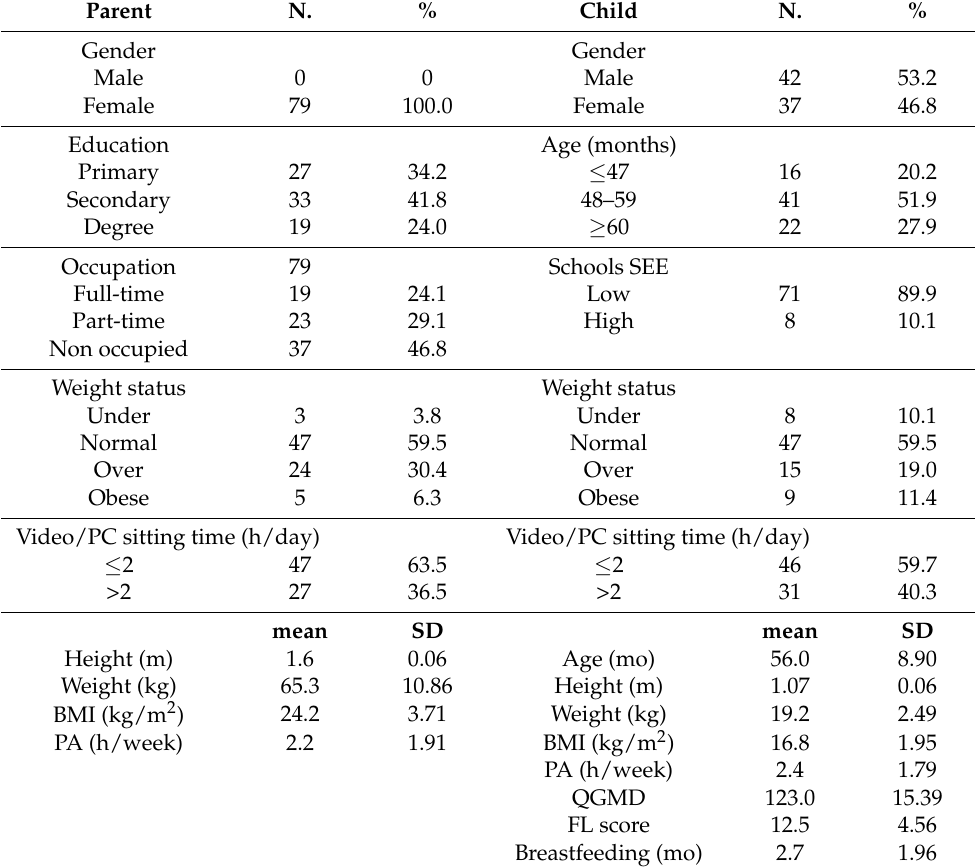
Table 1. Characteristics of the 79 dyads of mothers and children participating in the Training-to- Health Project.